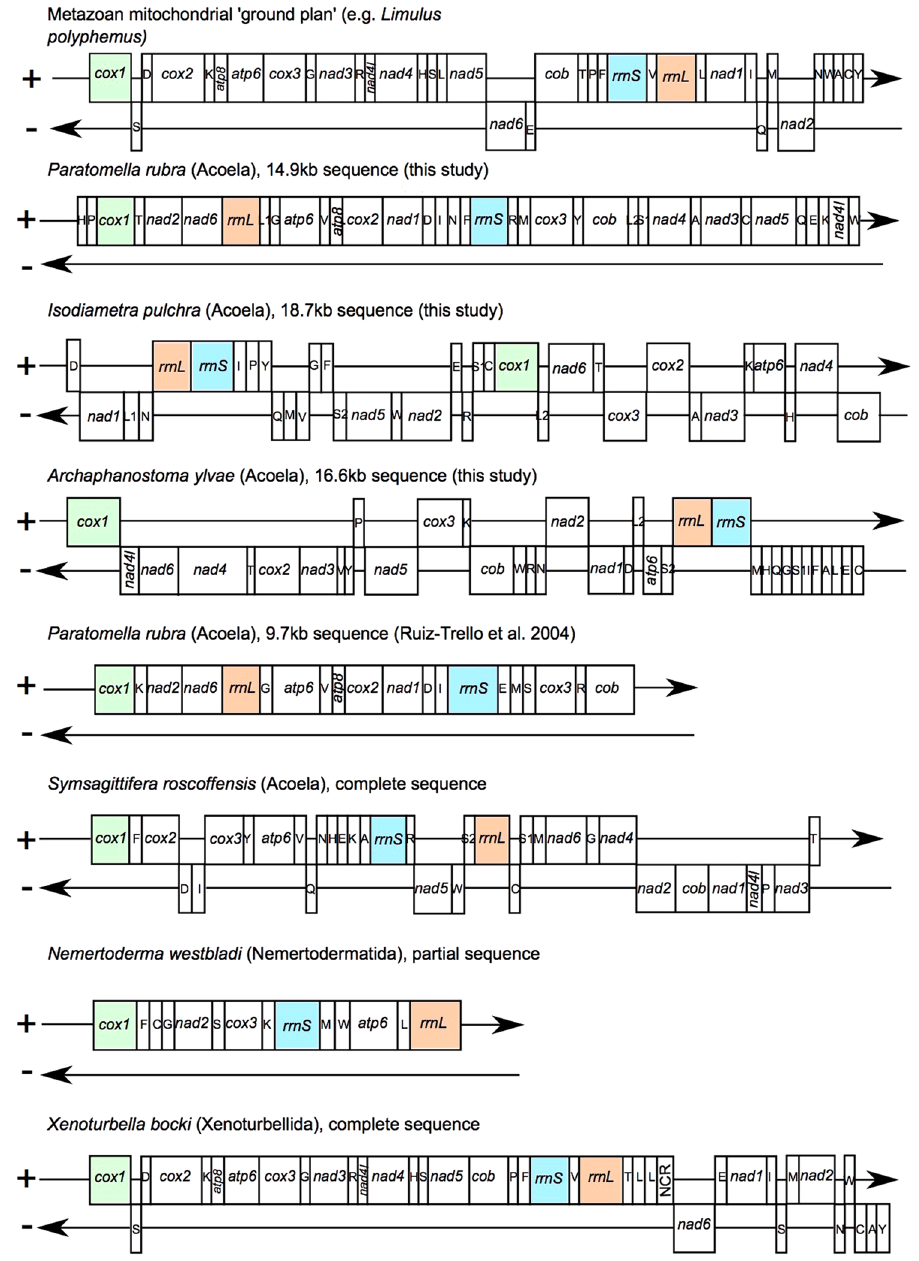
Figure 6. Comparisons of gene orders in the mitochondrial genome sequences resolved for Paratomella rubra , Isodiametra pulchra and Archaphanostoma ylvae compared to a published P. rubra fragment; the acoel Symsagittifera roscoffensis ; the xenoturbellid Xenoturbella bocki ; the nemertodermatid Nemertoderma westbladi and the metazoan mitochondrial ‘ground plan’ gene order, represented by Limulus polyphemus . Genes are not drawn to scale. Coloured genes chosen to show ‘anchors’ and divergence from the ground plan gene order in other